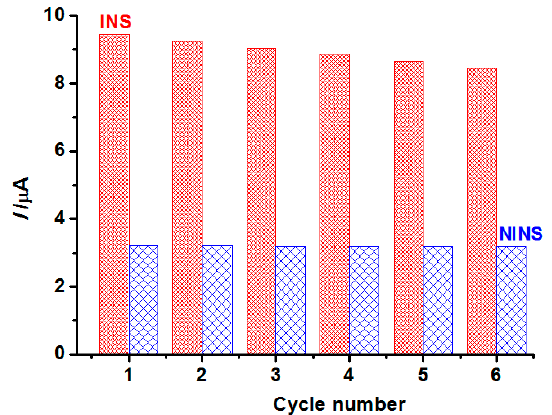
Figure 11. The regeneration of the INS/NINS.